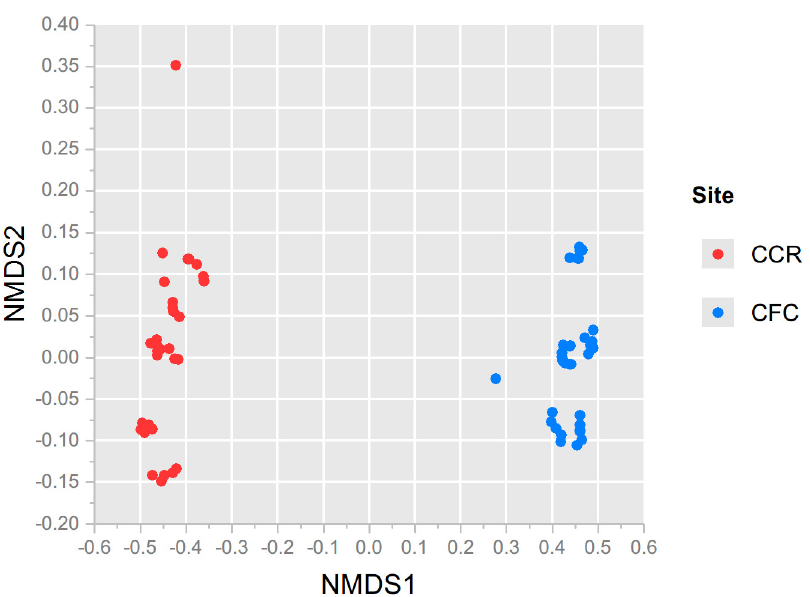
Fig 5. Nonmetric Multidimensional Scaling Plot of samples from CCR and CFC. Plot is based on a Bray- Curtis distance matrix generated from rarefied taxon abundances.